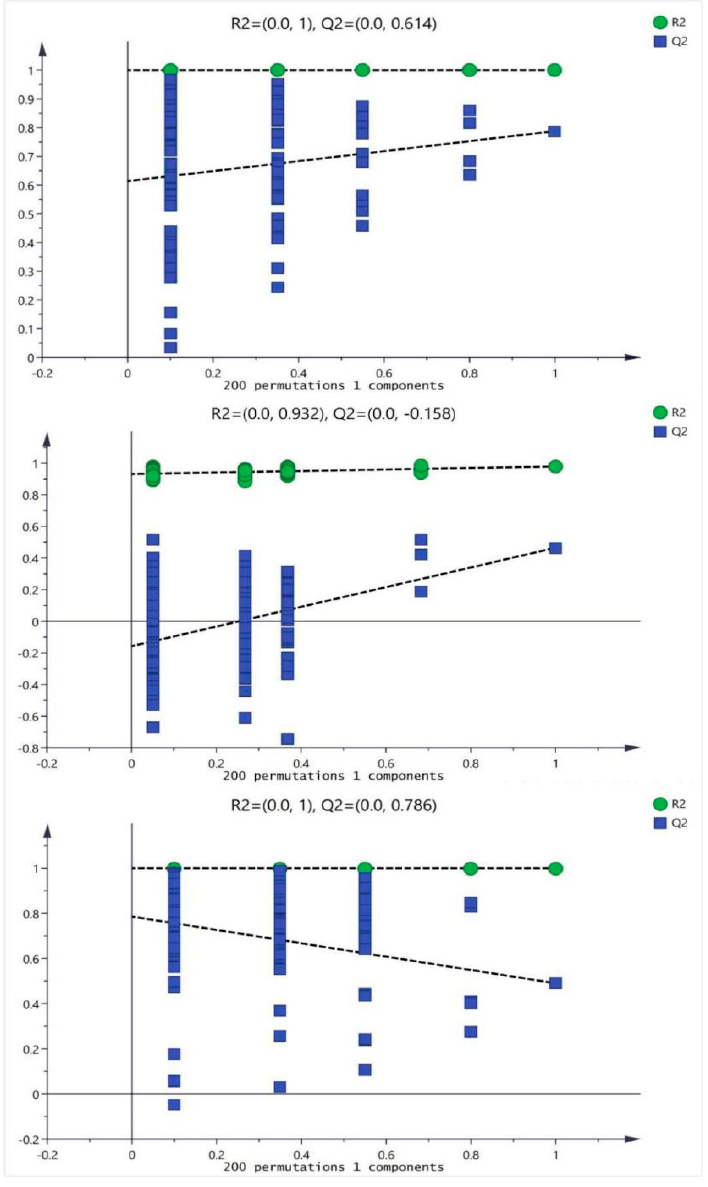
Figure 4. The validation plots of the OPLS-DA models, generated from the seven-cycle interactive verification and 200-response ranking tests with the corresponding predictive principal component. The green square is R2 (cum), denoting the explained variance of the model. The blue diamond is Q2 (cum), standing for the predictive ability of the model. The three pictures from top to bottom represented the artesunate (ART) group (20 mg / kg); ursolic acid(U) group (20 mg / kg) and combination (F) group (artesunate 20 mg / kg + ursolic acid 20 mg / kg),